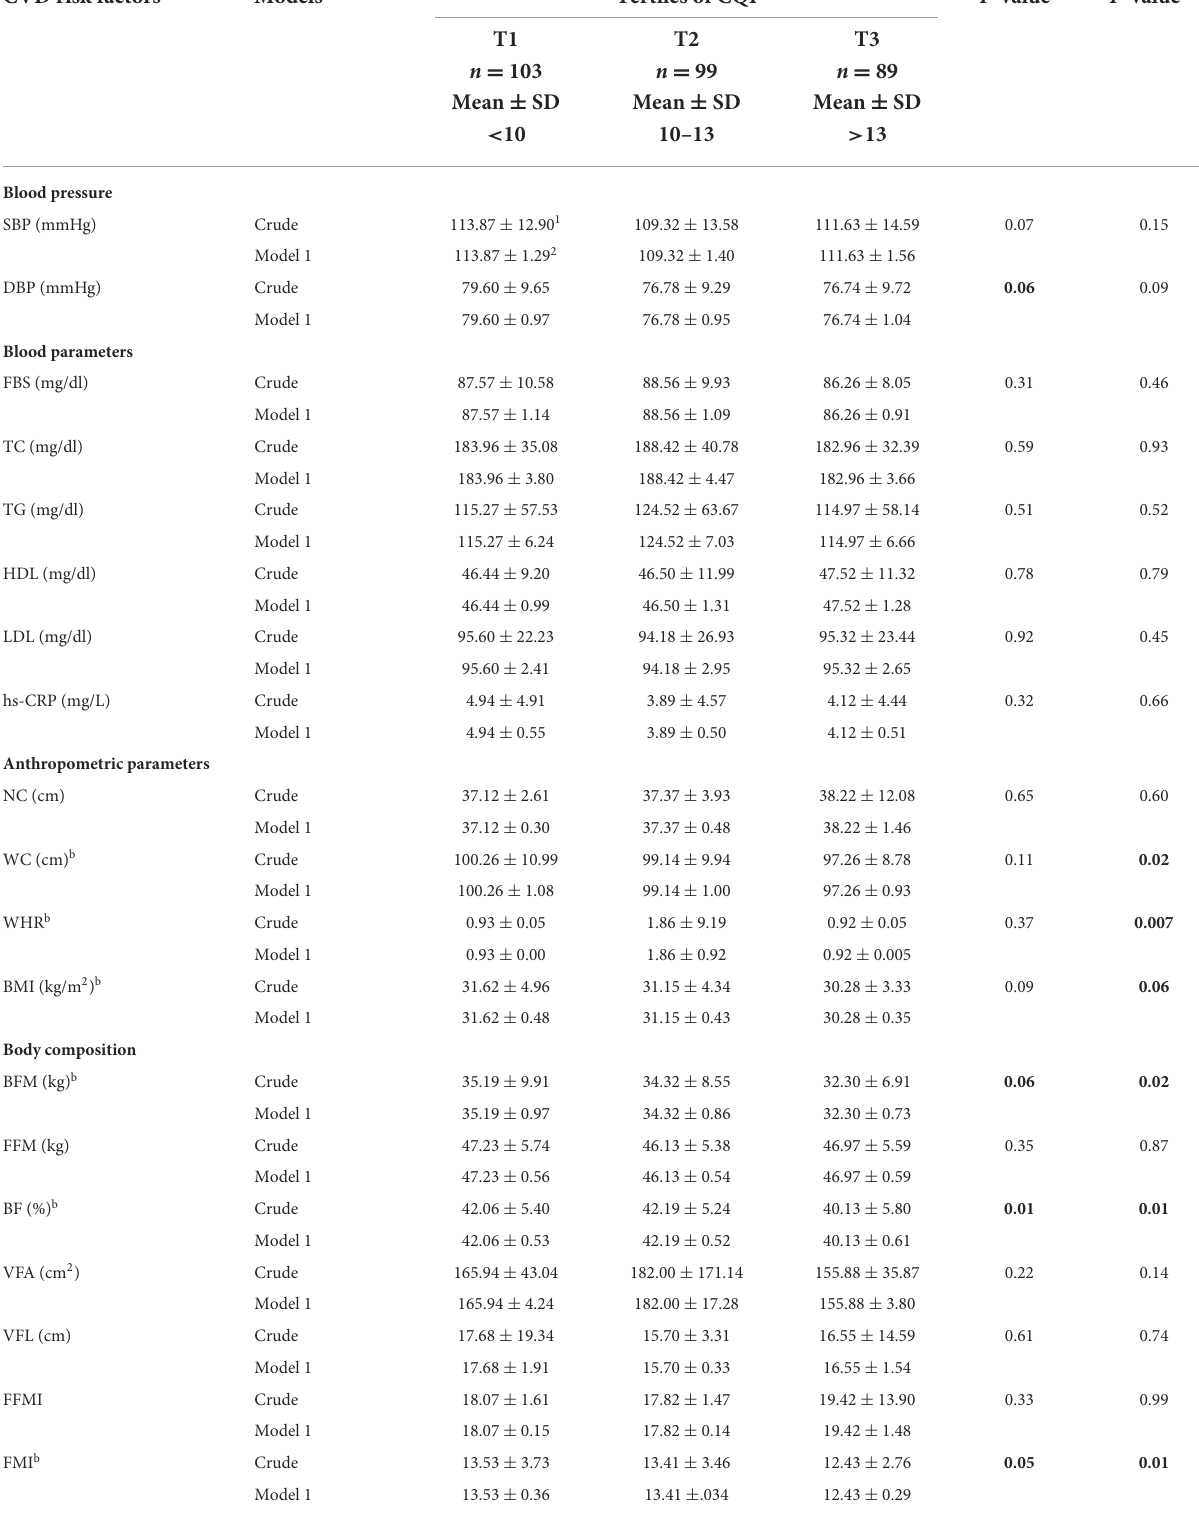
TABLE 4 CVD risk factors, anthropometric measures, and body composition of study participants among tertiles of the CQI ( n = 291). CVD risk